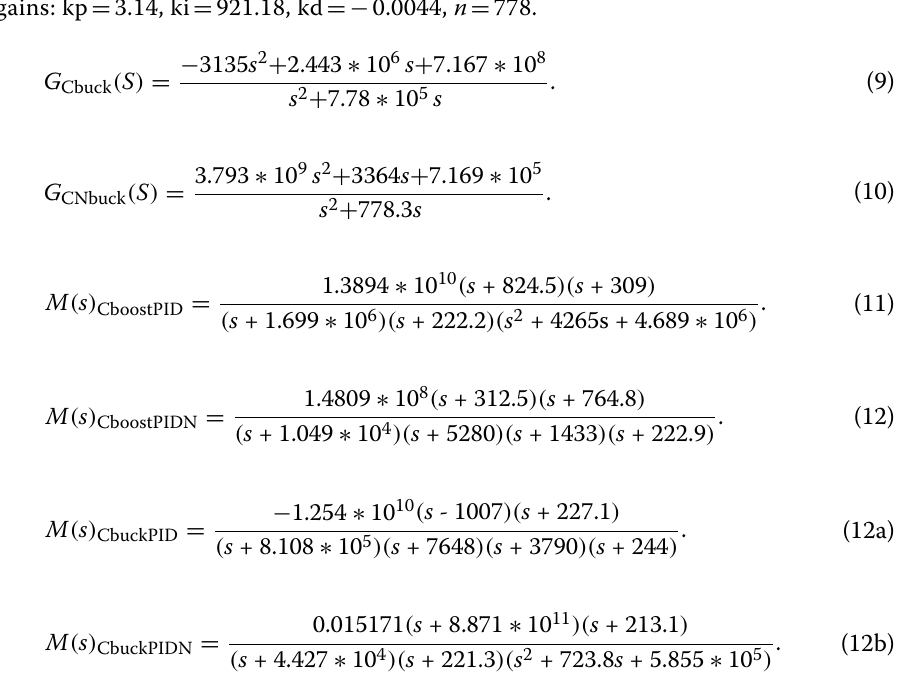
For buck mode, analog closed-loop controllers are designed with PID control who’s transfer function is given in Eq. (9) and PIDN control who’s transfer function is given in Eq. (10) with gain values which are obtained by autotuning of transfer function model of each mode of BBC in MATLAB